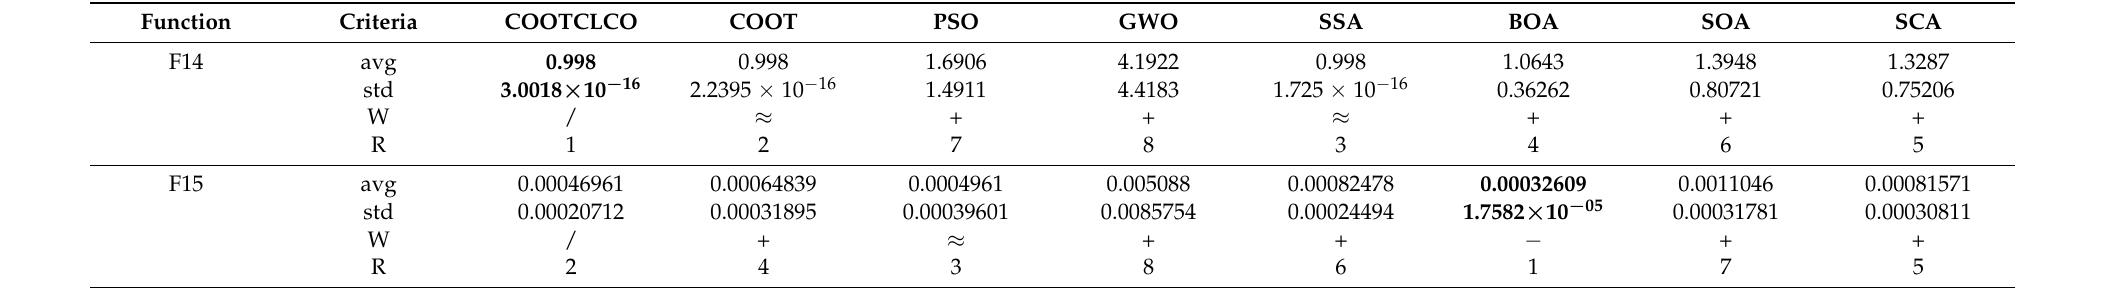
Table 7. Results of fixed-dimension multimodal benchmark